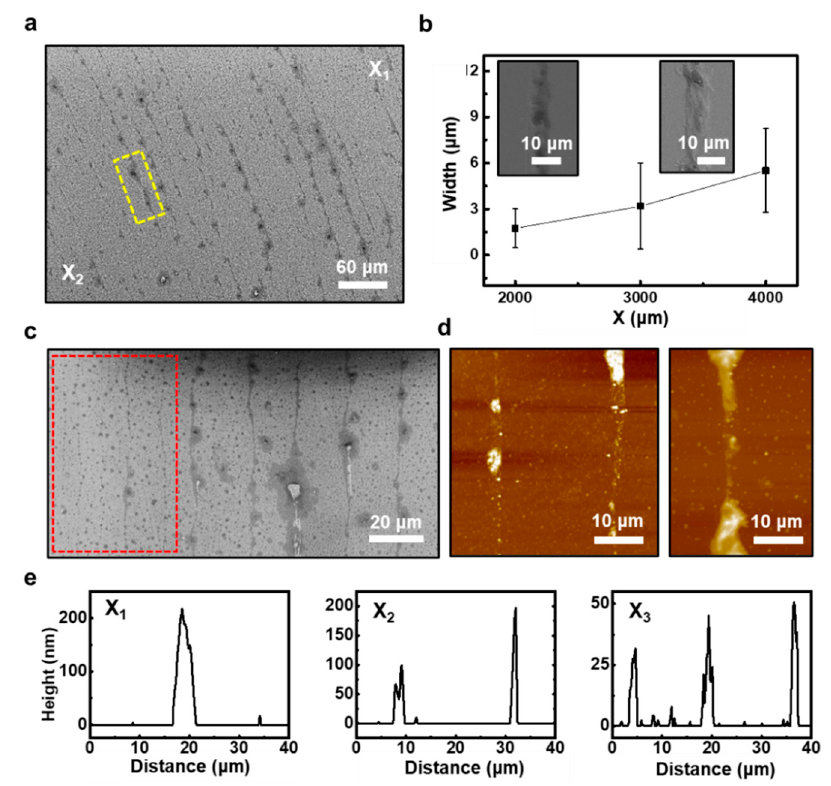
Figure 4. Dimensional configuration of the perovskite QD ring patterns. ( a ) SEM image of the perovskite QD multiple ring patterns. ( b ) The width of a single perovskite QD ring decreases as distance decreases from the contact-center. Inset SEM images show the width at 4000 µ m and 2000 µ m from the contact-center, respectively. ( c ) SEM image shows an array of narrow stripes in the innermost region that appeared with isolated QDs (the marked region with a dotted box). ( d ) Representative AFM images at the intermediate stage of the process; the magnified image of a single ring displays a nanostructured line induced from the weaker pinning force at the contact line in the deposition process. ( e ) The height transition of the multiple rings consisted of the perovskite QDs (i.e., CsPbBr 3 ), depending on the ring position on the substrate from 200 nm at X 1 to 25 nm at X 3 .